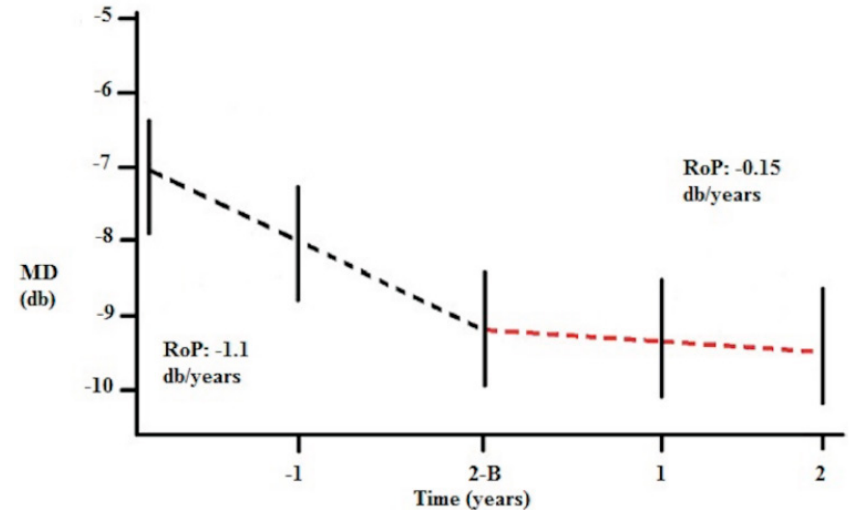
Figure 2. Rates of progression (RoP) during the study. B = Baseline. 2-B: two years before baseline. (Figure adapted from Reference n [75]) .